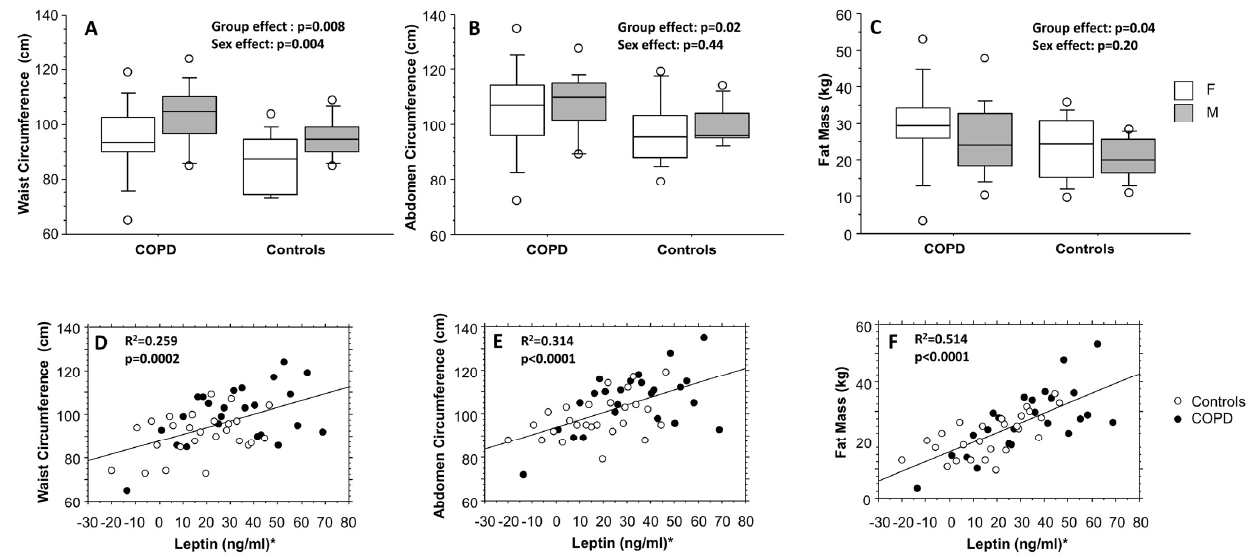
Figure 2. Waist circumference ( A ), abdomen circumference ( B ), and fat mass ( C ), separately for COPD and control groups and sex. Results from two-way analysis of variance. For each box plot, from the bottom to the top, horizontal lines display the 10th, 25th, 50th (median), 75th, and 90th percentiles of the values. Values below 10th percentile and above 90th percentile are plotted as circles. For both COPD and control groups, linear positive correlations between waist circumference ( D ), abdomen circumference ( E ), and fat mass ( F ) and leptin values. * Leptin values were normalized by mean and standard